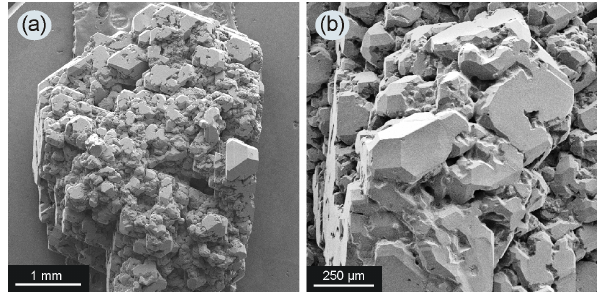
Figure 4. Diamond crystal grown in the Fe–Ni–C system with the addition of 10wt% silicates (run 2–44, assembly configuration shown in Fig. 1a): (a) while maintaining the appearance of an octa- hedral crystal, the diamond grew as a parallel aggregate of numer- ous individuals; (b) enlarged fragment of the same crystal – each diamond subindividual has numerous faceted caverns on its